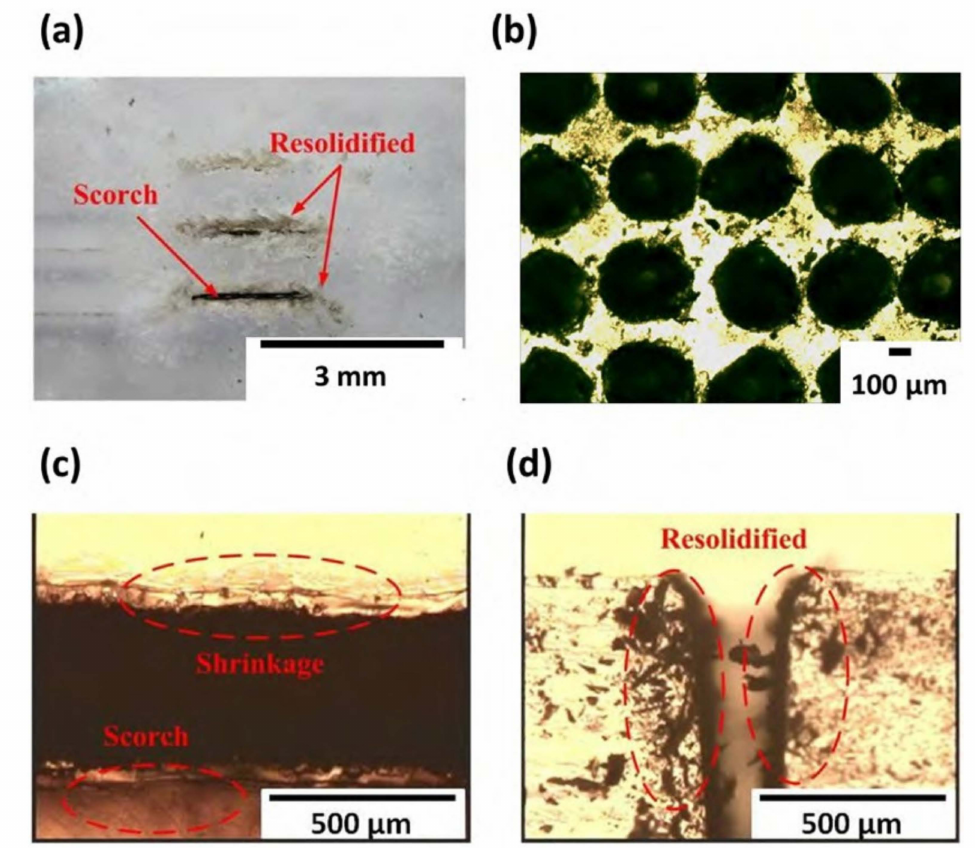
Figure 5. Optical micrographs of the direct CO 2 laser ablated PDMS channels in air: ( a ) The full view sample of three ablated channels, and ( b ) the ablated holes array, ( c ) the top-view channel rims with the defects of shrinkage and scorch around the rim of channels, and ( d ) the cross-sectional channel with the re-solidified object on the